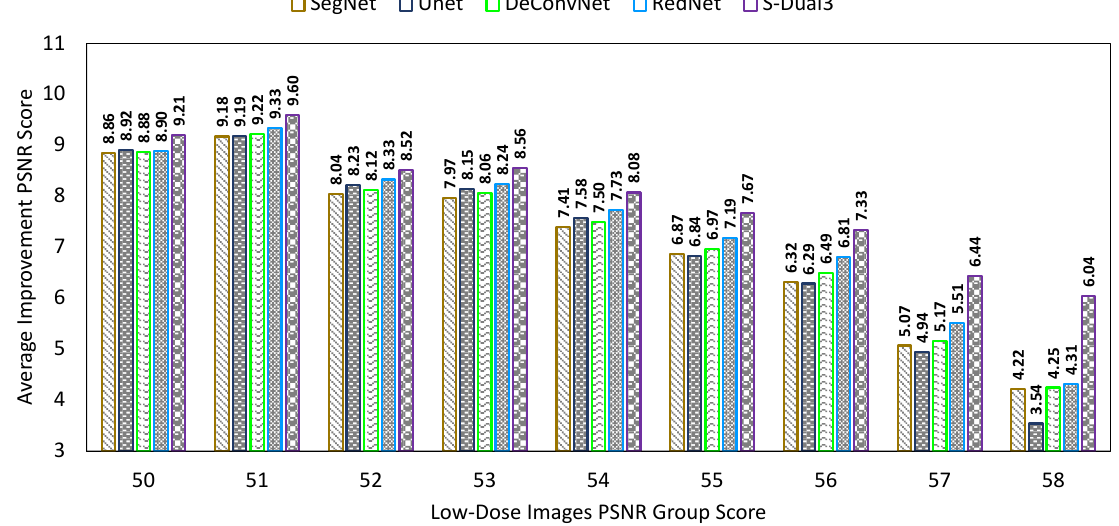
Figure 16. Comparison chart of PSNR scores from different CNN models with a new data